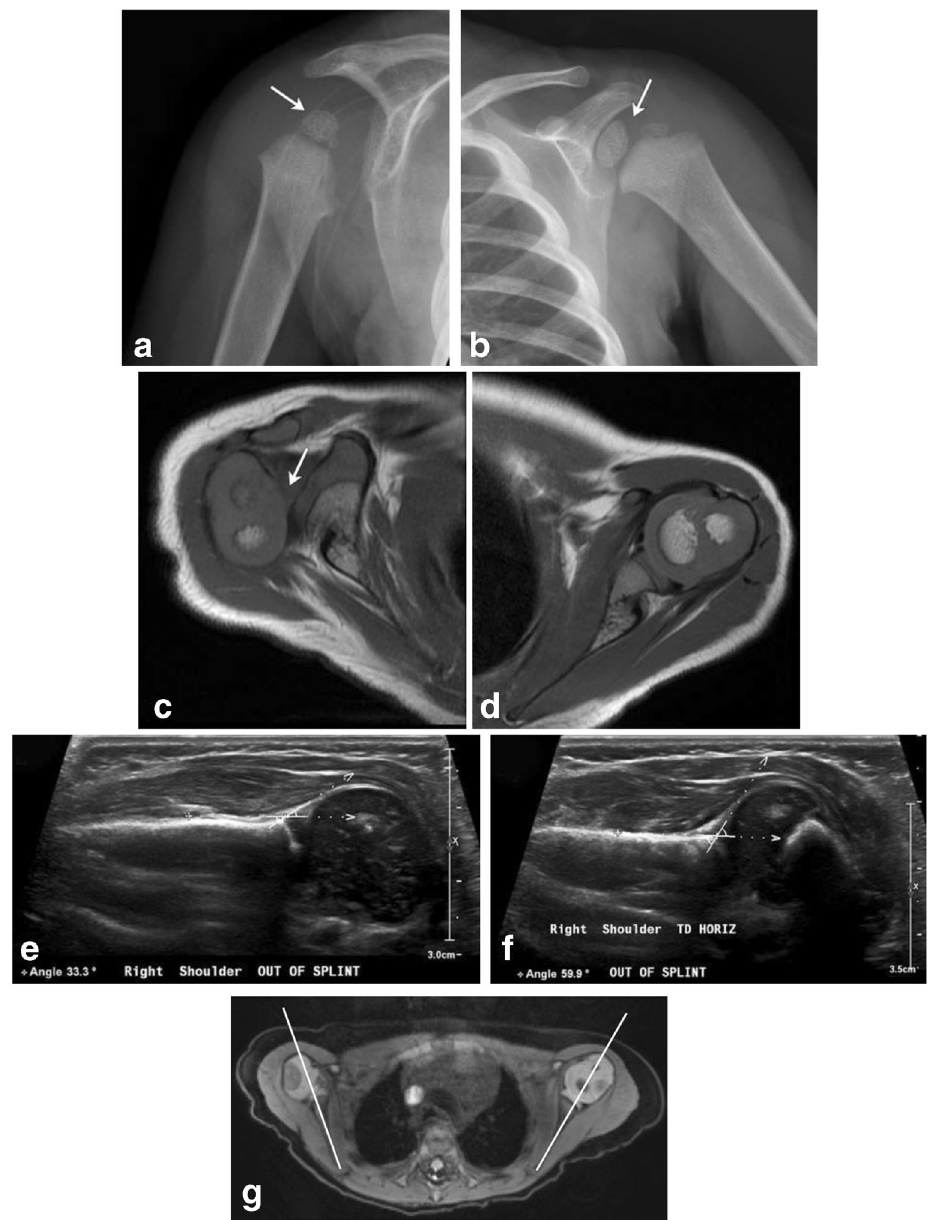
Fig. 14 Glenohumeral dysplasia in two neonates Follow-up shoulder imaging in a 13-month-old child with clinically suspected brachial plexus palsy at birth (a-c). He subsequently developed glenohumeral dysplasia. The right humeral head is small, glenoid is shallow as seen on the radio- graph (a); compare with the normally formed left humeral head and glenoid labrum (b). Axial T1 MR image (c) reveals posterior subluxation of humeral head; compare to normally aligned left humeral head (d).